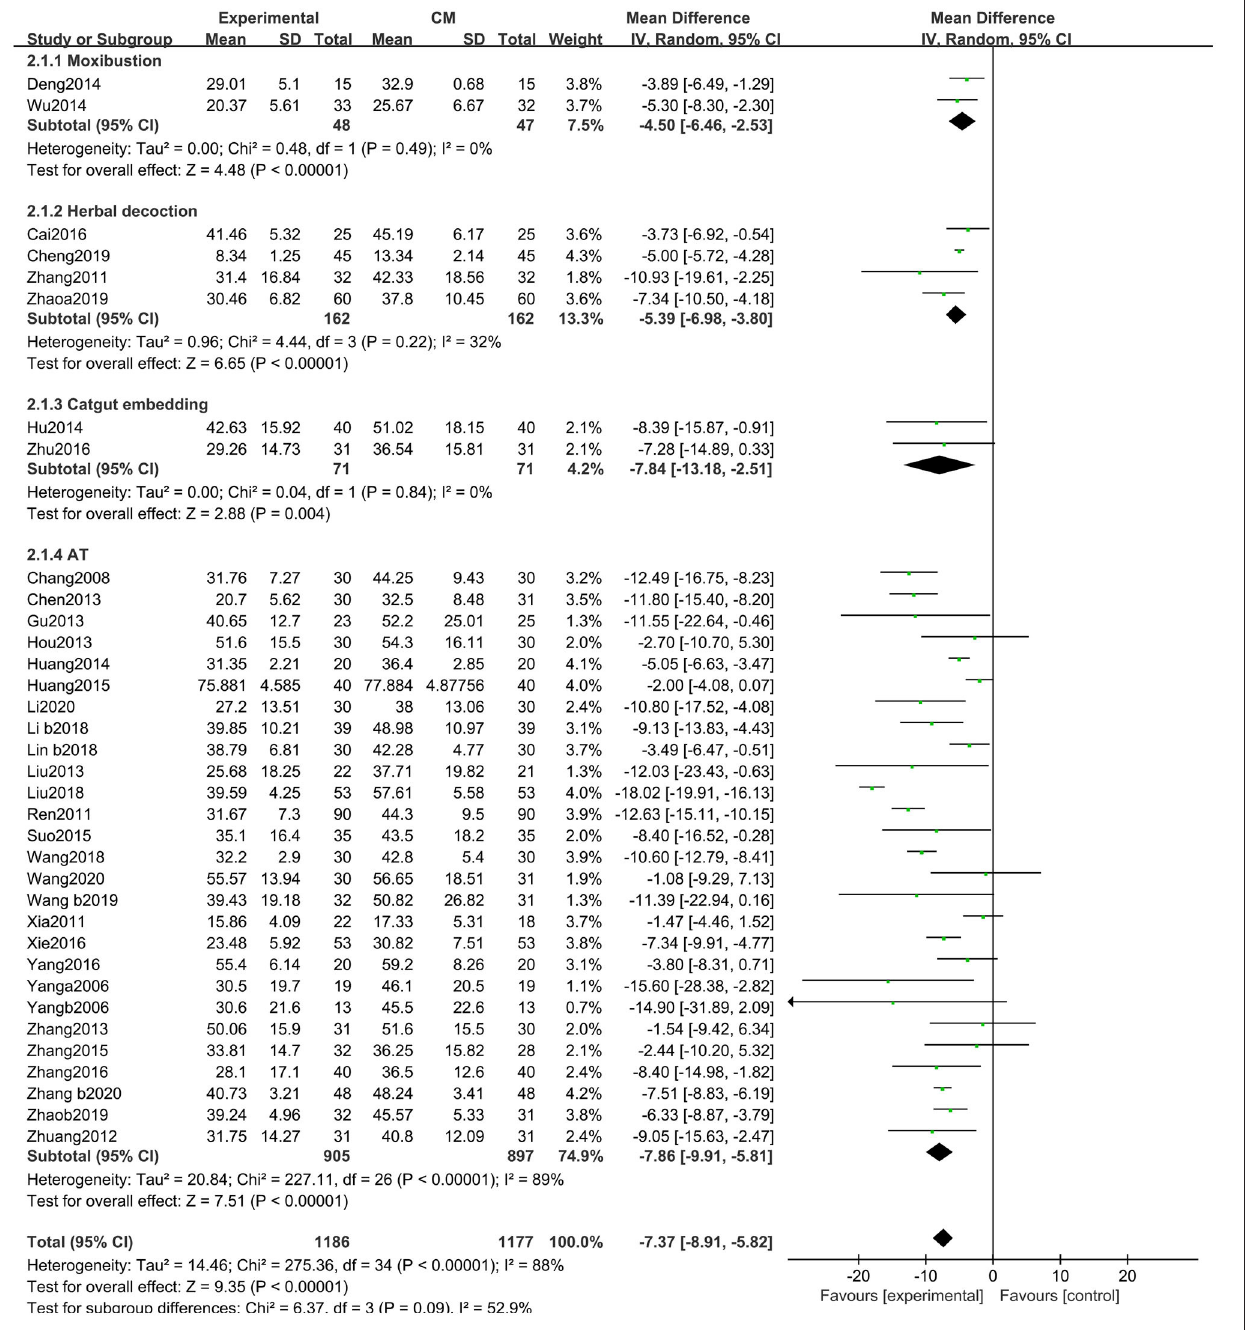
Dosage of Madopar showed differences in the treatment effects between the different interventions. However, since the data within each method were limited and these comparisons were based on indirect comparisons, the results should be interpreted with